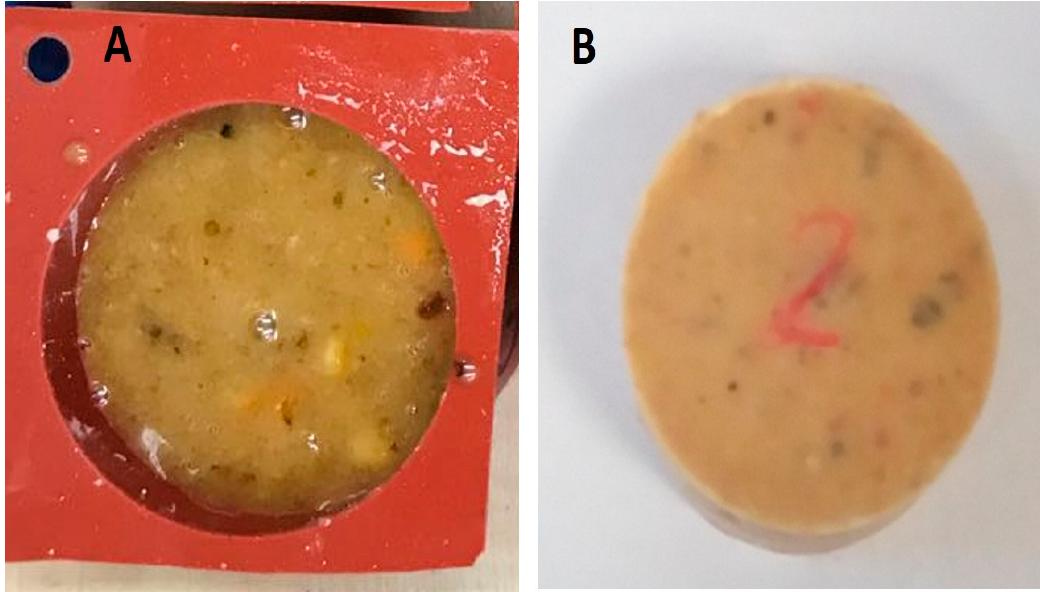
Figure 3. Pictures of the urea formaldehyde (UF)/ organic fraction of municipal solid waste (OFMSW)